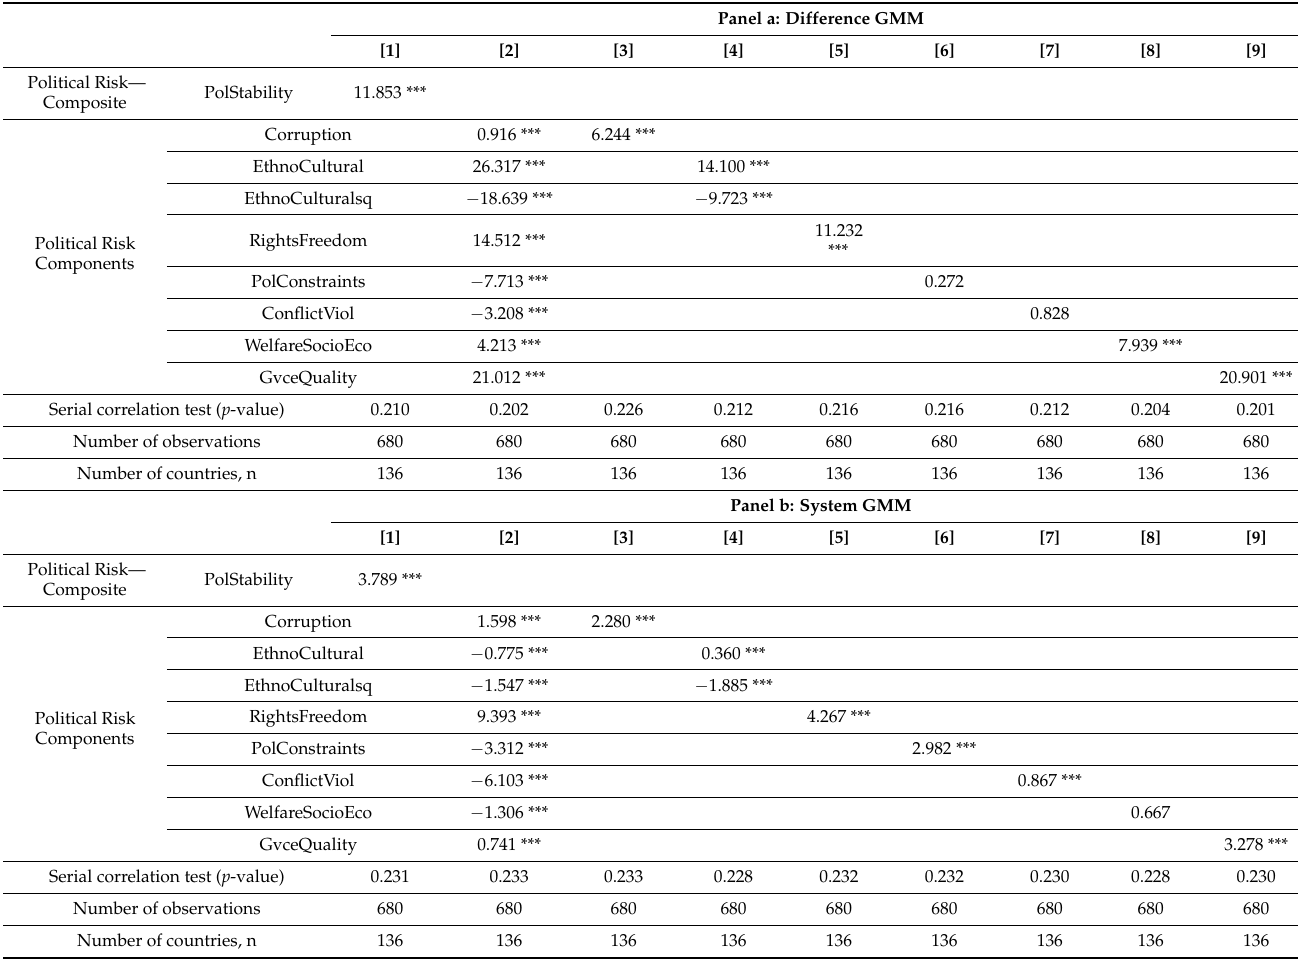
Table 5. Political Risk and FDI Revisited—Dynamic Panel Data